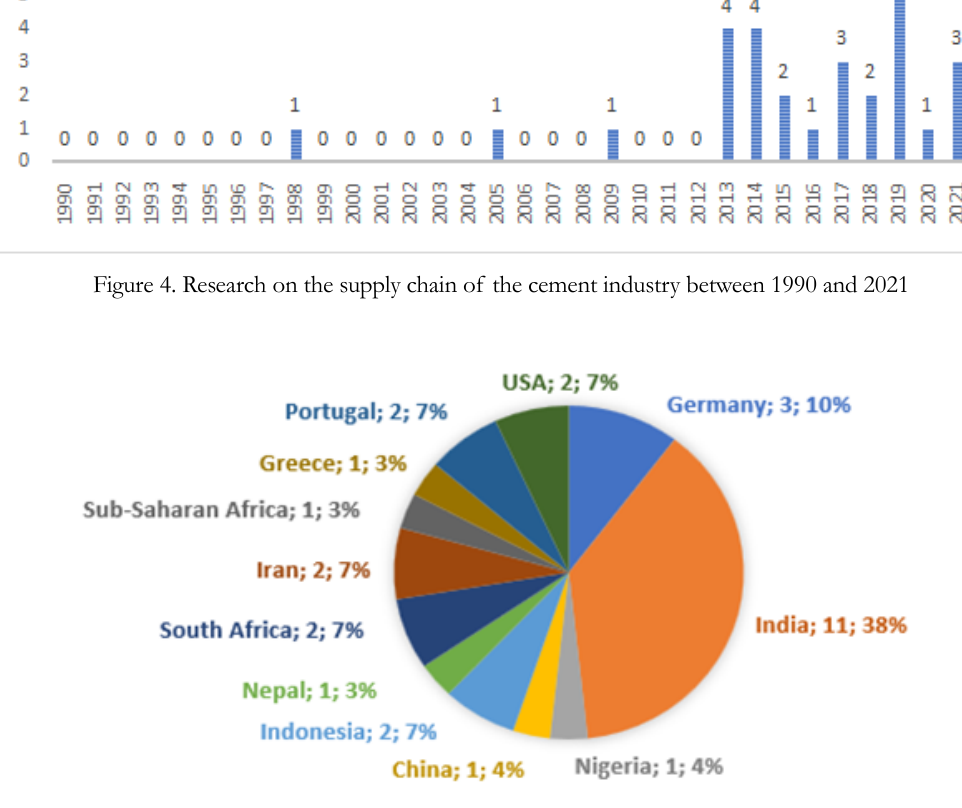
Figure 5. Articles on strategic supply chain management in the cement